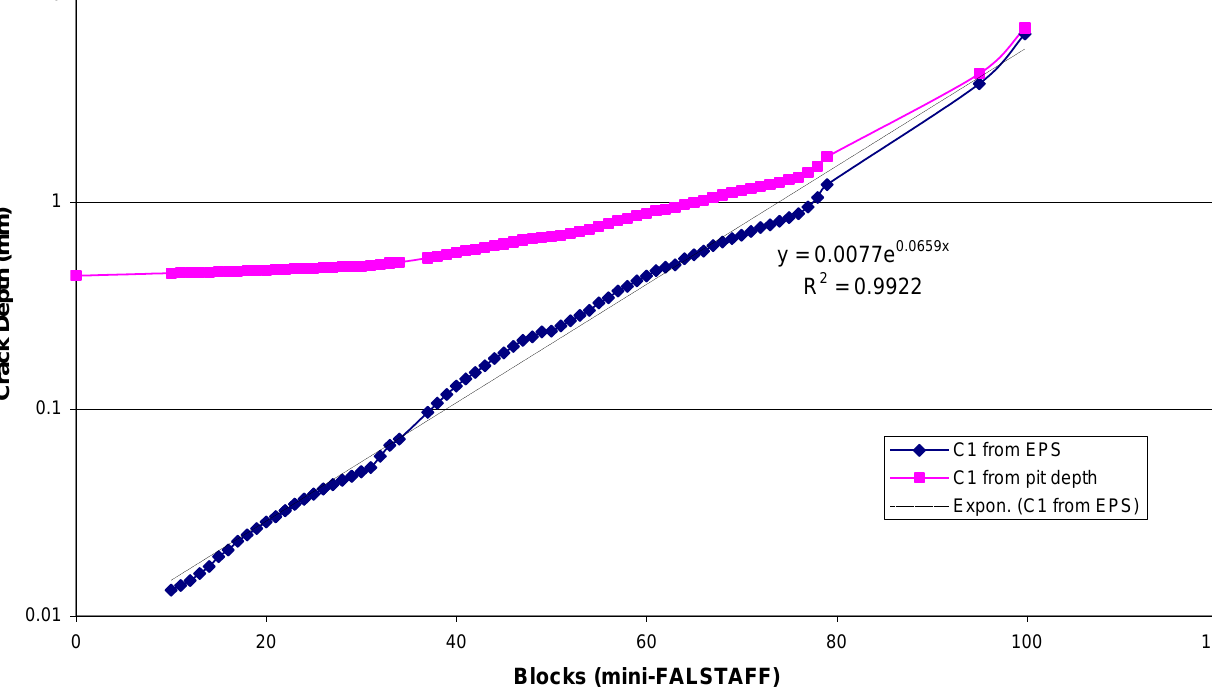
Figure 11 . Fatigue crack growth from the corrosion pit in the Y488 bulkhead flange. Individual data points represent a simulated flight block of the spectrum (mini-FALSTAFF). The plots show the original and empirically adjusted logarithms of the crack depths versus life on a linear scale. The empirical adjustment was based on the expectation of lead crack exponential growth. This adjustment suggests the pit depth of 440 µm was equivalent to an EPS of approximately 7.7 µm (see main text).